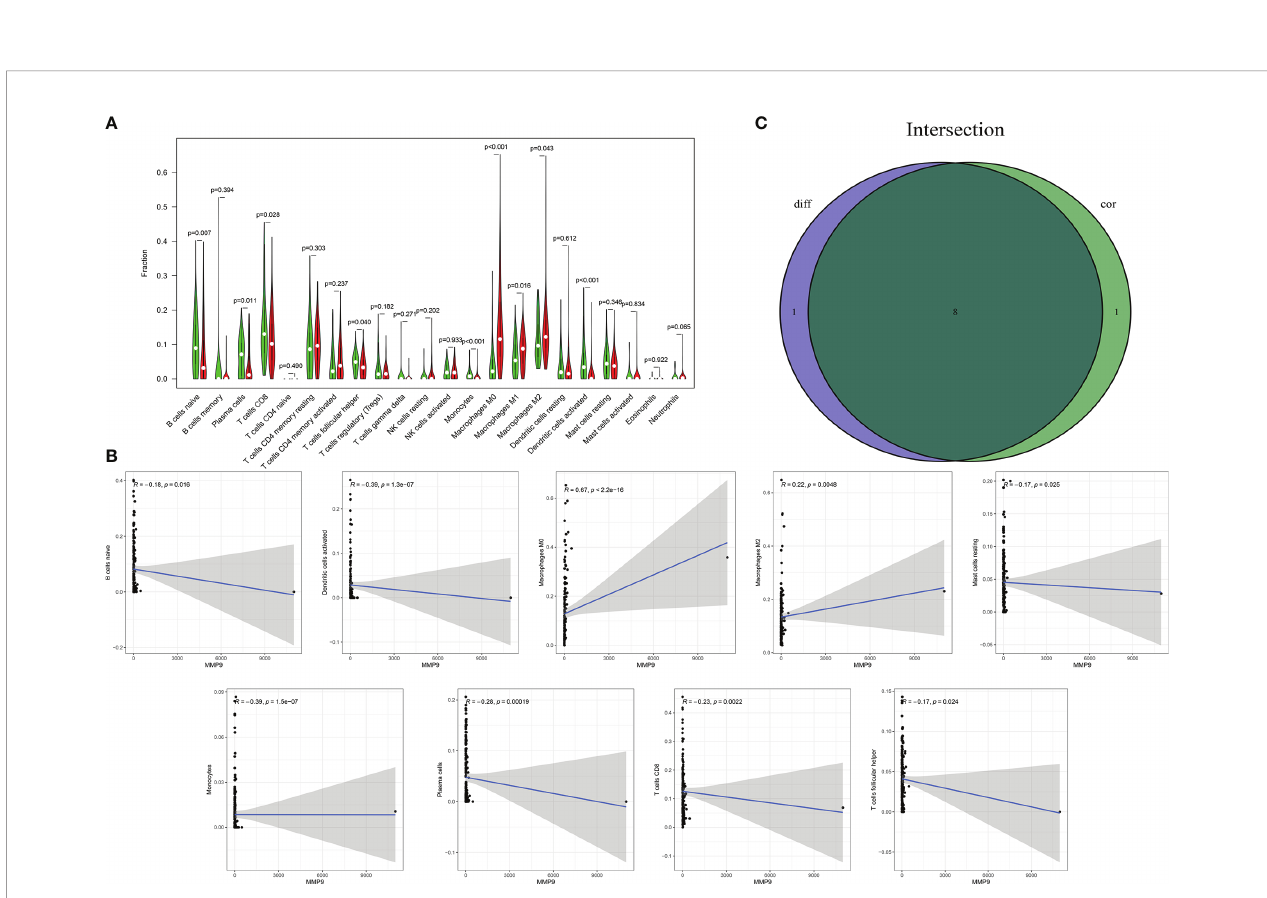
FIGURE 13 | Signi fi cant correlation between the expression of MMP9 and the fractions of tumor-in fi ltrating immune cells. (A) Violin plot showing the comparisons between 22 types of tumor-in fi ltrating immune cells with MMP9 expression. (B) The correlation tests showing the correlation between 10 types of tumor-in fi ltrating immune cells proportion with the MMP9 expression (all p < 0.05). (C) Venn plot showing the collective TICs between the difference and correlation